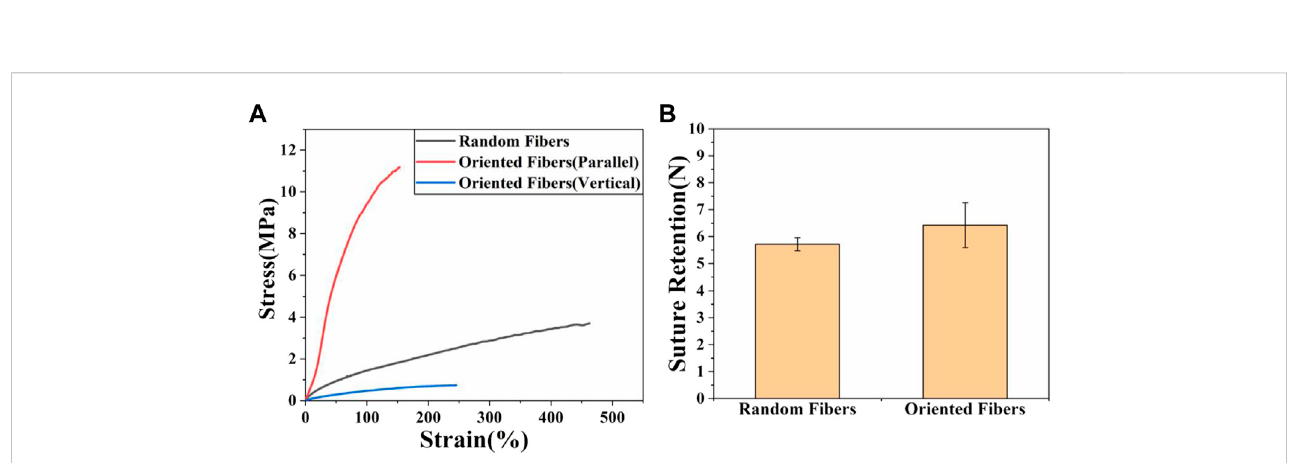
FIGURE 2 Mechanical properties of random- and oriented- fi ber membranes. (A) Stress – strain of random- and oriented- fi ber membranes parallel and perpendicular to fi ber direction, respectively, at a tensile speed of 5 mm min − 1 (N = 4). (B) Suture retention of random- and oriented- fi ber tube grafts at a tensile speed of 120 mm min − 1 (N =